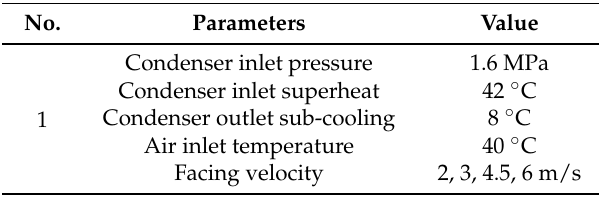
Table 3. Condenser performance simulation conditions.